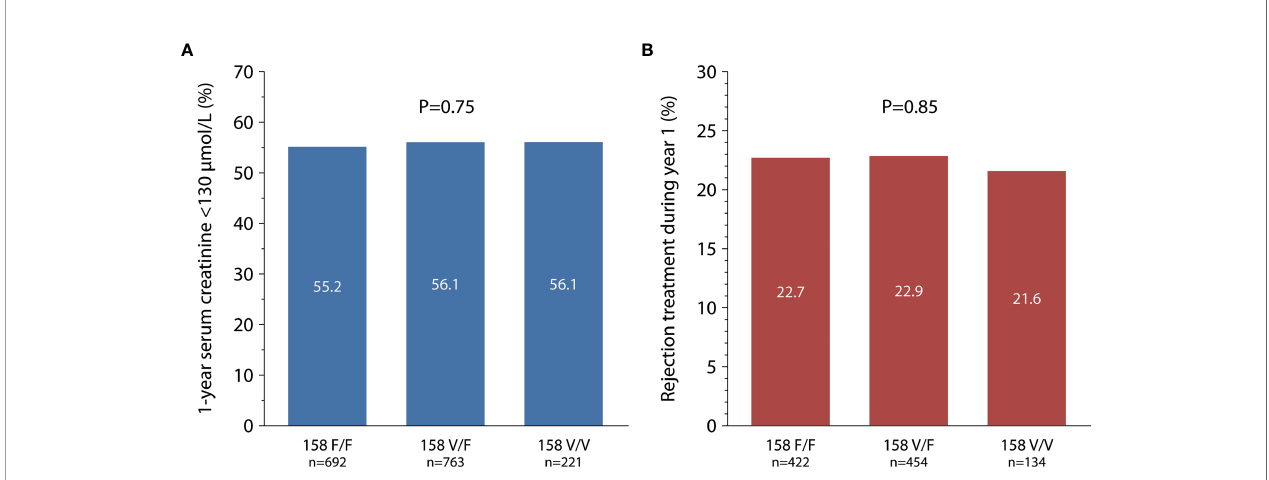
FIGURE 2 | FCGR3A -V/F 158 polymorphism in relation to 1-year serum creatinine [ (A) total 1,676 recipients] and treated rejection episodes within the fi rst year after transplantation [ (B) total 1,010